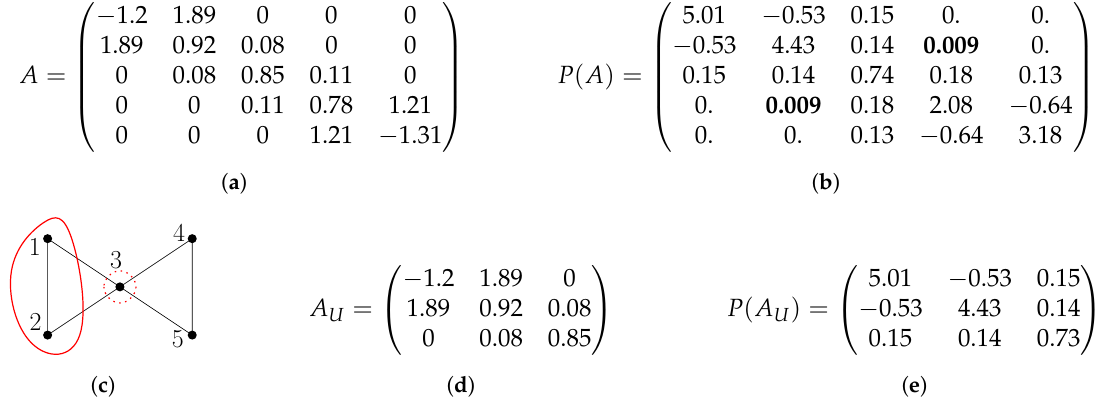
Figure 1. Example of using CH-partitioning for distributed evaluation of matrix polynomial P ( A ) = A 2 , with a thresholding operator that removes all edges/matrix entries with values below 0.01. ( a ) Input symmetric matrix A . ( b ) P ( A ) = A 2 . ( c ) After the thresholding operator removes elements ( 2,4 ) and ( 4,2 ) (in bold) from P ( A ) , the sparsity graph P ( G ) of the resulting matrix is shown. We are considering a block of a CH-partitioning with core set U = { 1,2 } (encircled with a solid line) and halo the set H = { 3 } (encircled with a dashed line). ( d ) Submatrix A U consisting of the first three (by U ∪ H = { 1,2,3 } ) rows and columns of A . ( e ) Matrix P ( A U ) = A 2 . According to Lemma 1, U the elements of the first two (by U = { 1,2 } ) columns/rows of P ( A U ) are equal to the corresponding nonzero elements of the first two columns/rows of thresholded P ( A )